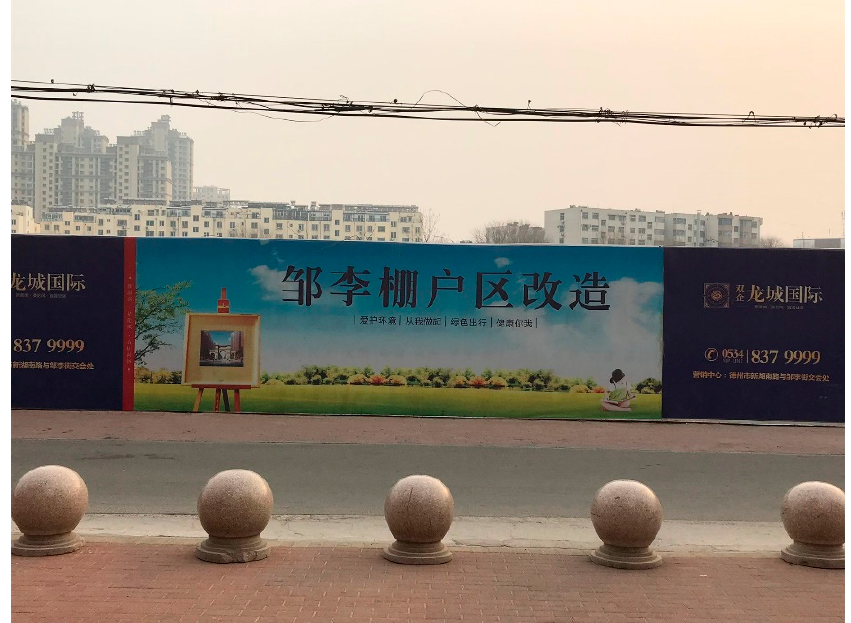
Figure 1. Zouli shantytown redevelopment in Dezhou, Shangdong, 2019. Source: photographed by the author.